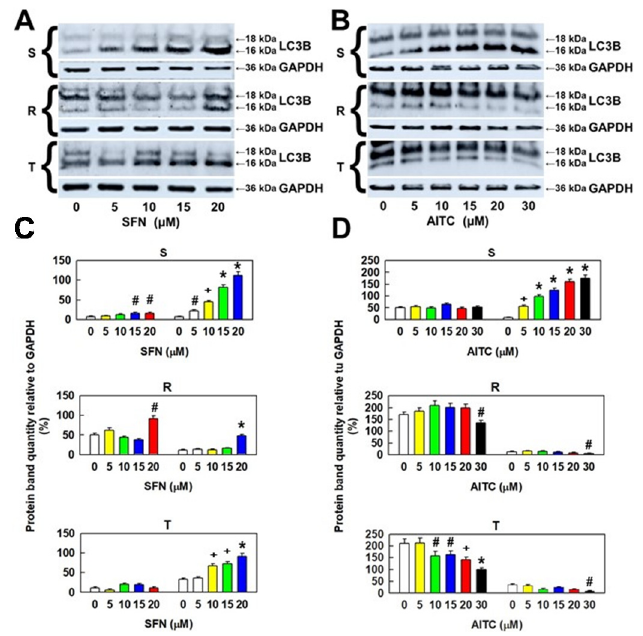
Figure 7. Cellular levels of LC3B protein variants in S, R and T cells after incubation in medium containing different concentrations of SFN or AITC for 24 h. Panels A and B : Detection of proteins by Western blotting. GAPDH was used as an internal control. Data are representative of three independent measurements. Panels C and D : Densitometric quantification of protein bands from the Western blots. Quantities are expressed as the mean ± S.E.M. from three independent measurements of data in relation to the GAPDH signal. Data differ from values obtained in cells that were not incubated in the absence of either SFN or AITC at the following levels: # – p < 0.05; + – p < 0.02; * – p < 0.01.